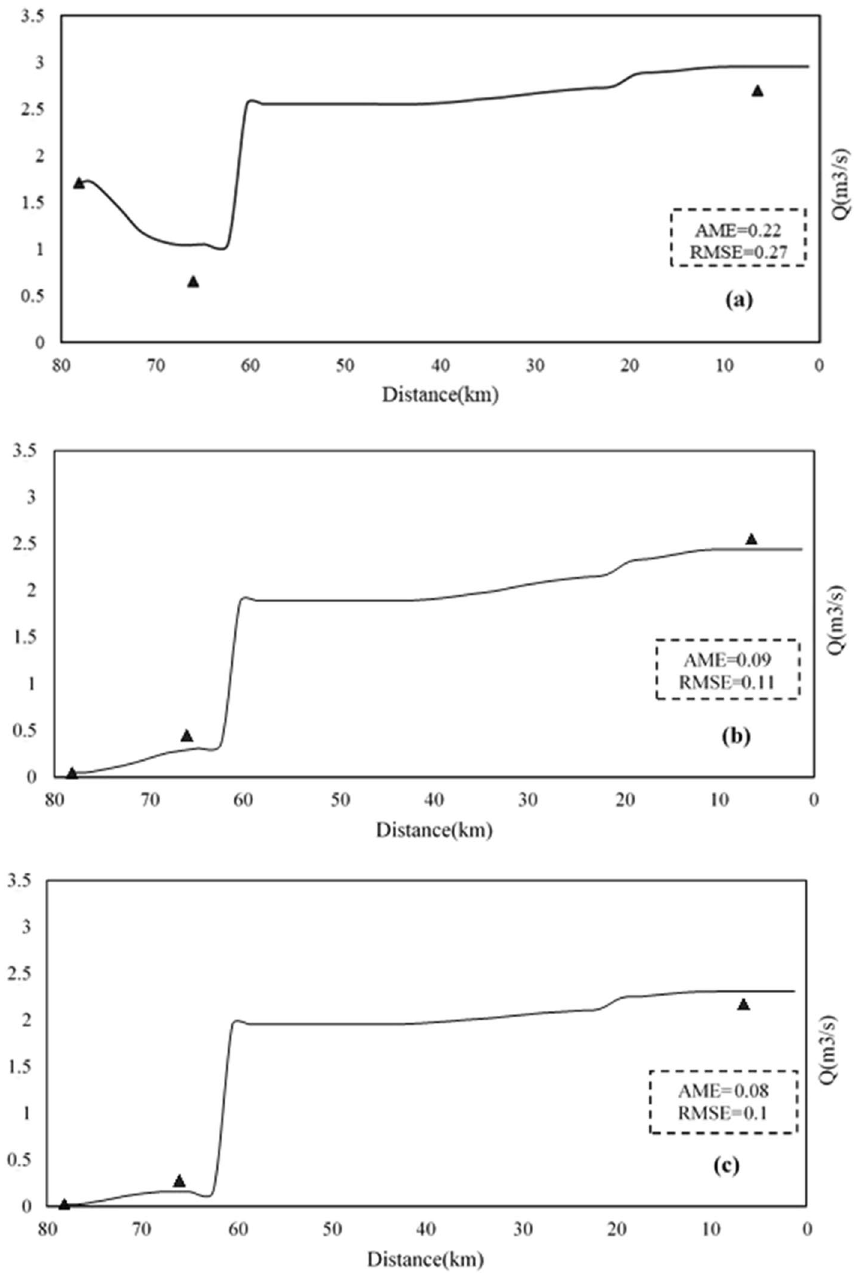
Figure 5. Discharge of Sarouq River in ( a ) spring, ( b ) autumn, ( c ) winter after